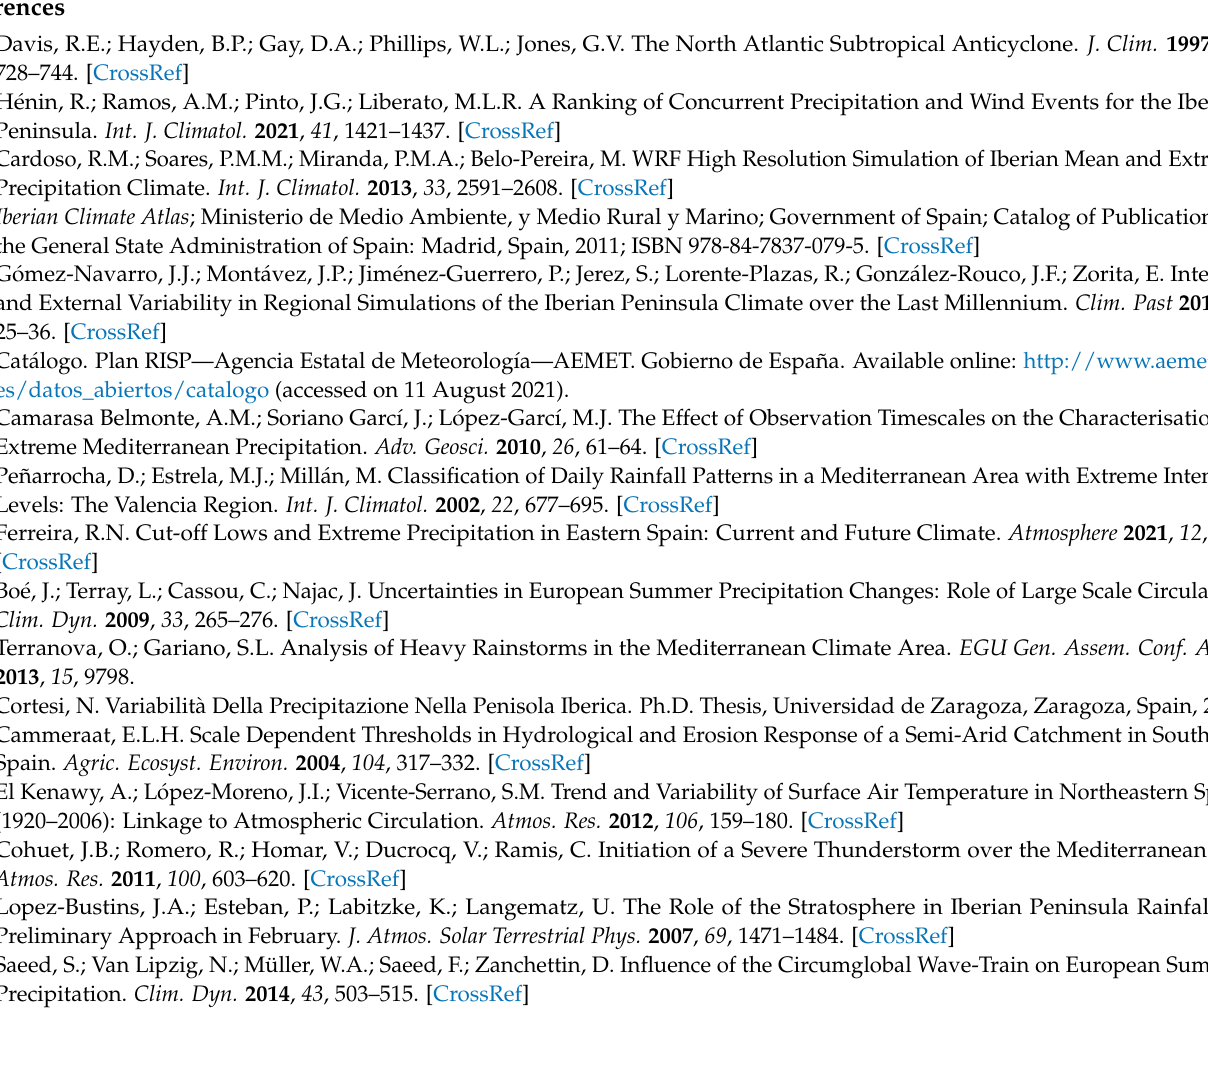
Figure S3: larger ver-sion of Figure 4b, Figure S4: larger version of Figure 4c, Figure S5: larger version of Figure 4d, Figure S6: larger version of Figure